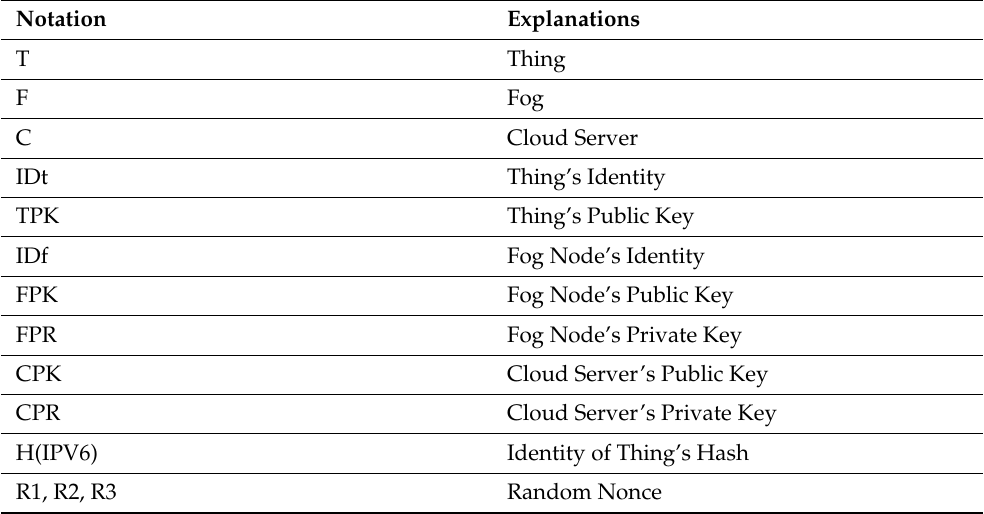
Table 2. Notations and